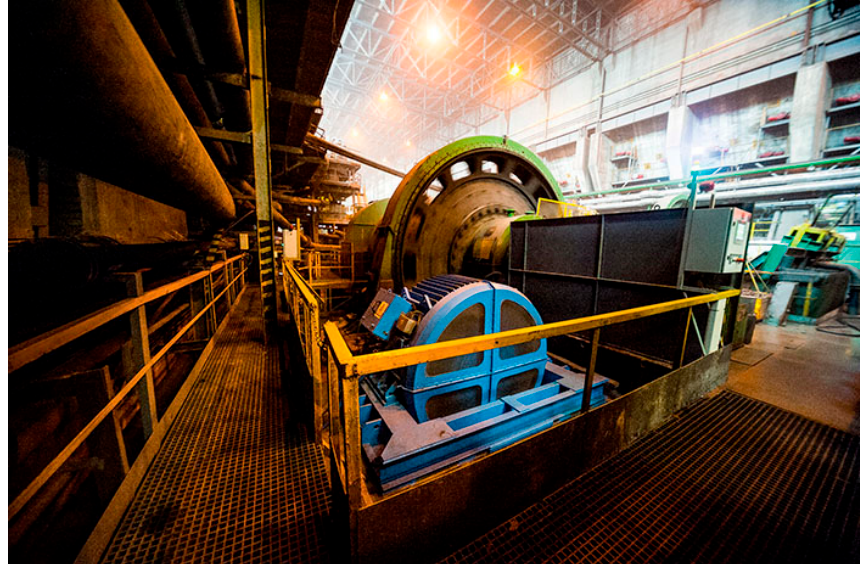
Figure 4. New ball mill drive system with the prototype energy-saving SMH motor [37].